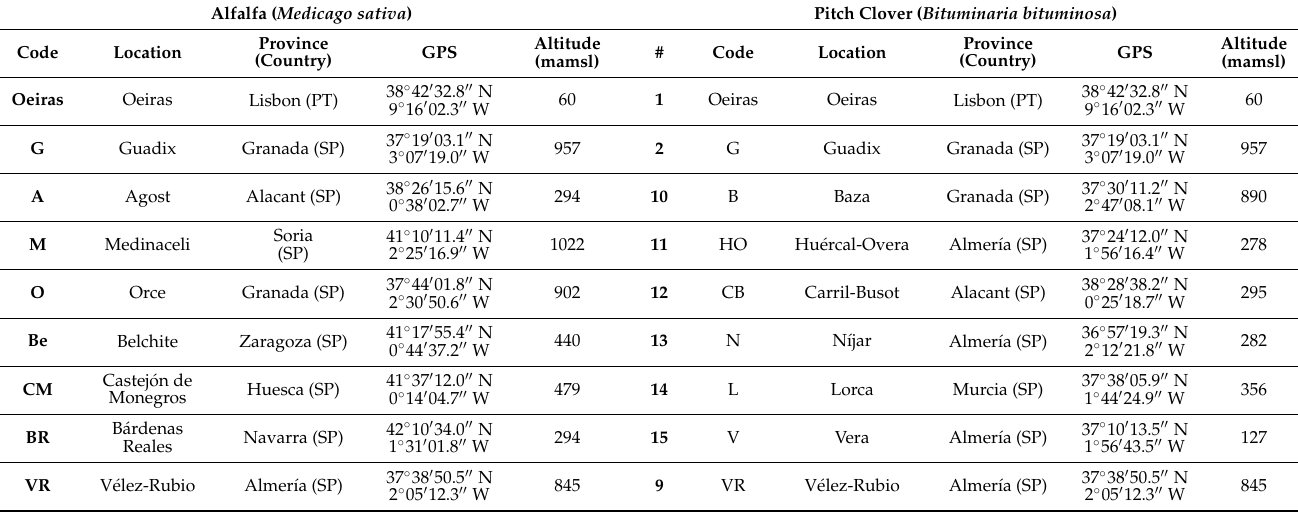
mamsl stands for meters above mean sea level.